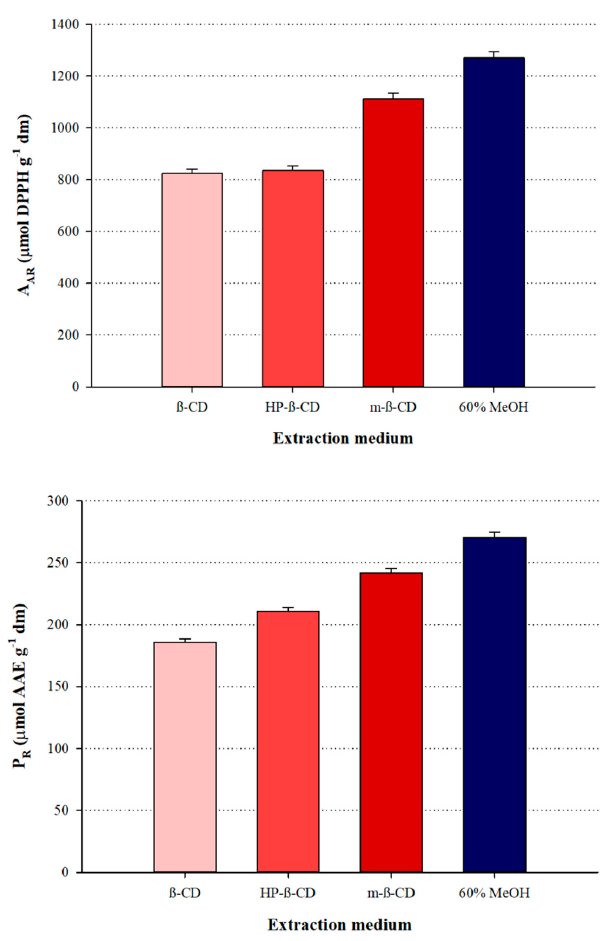
Figure 6. Diagram illustrating the A AR and P R of the extracts produced using each of the CDs tested, under optimized conditions, after 180 min, at 80 °C. Assignments: m- β -CD, methyl β -cyclodextrin; HP- β -CD, hydroxypropyl β -cyclodextrin; β -CD, β -cyclodextrin.